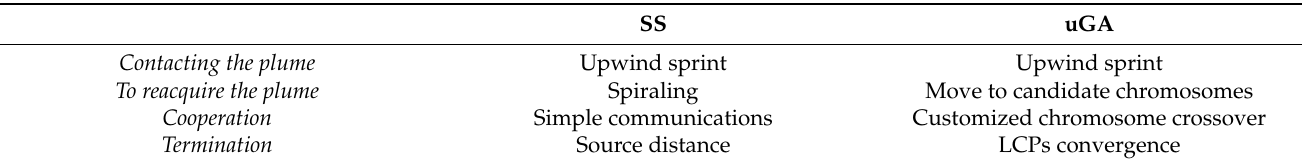
Table 2. Similarity and differences between the SS and uGA